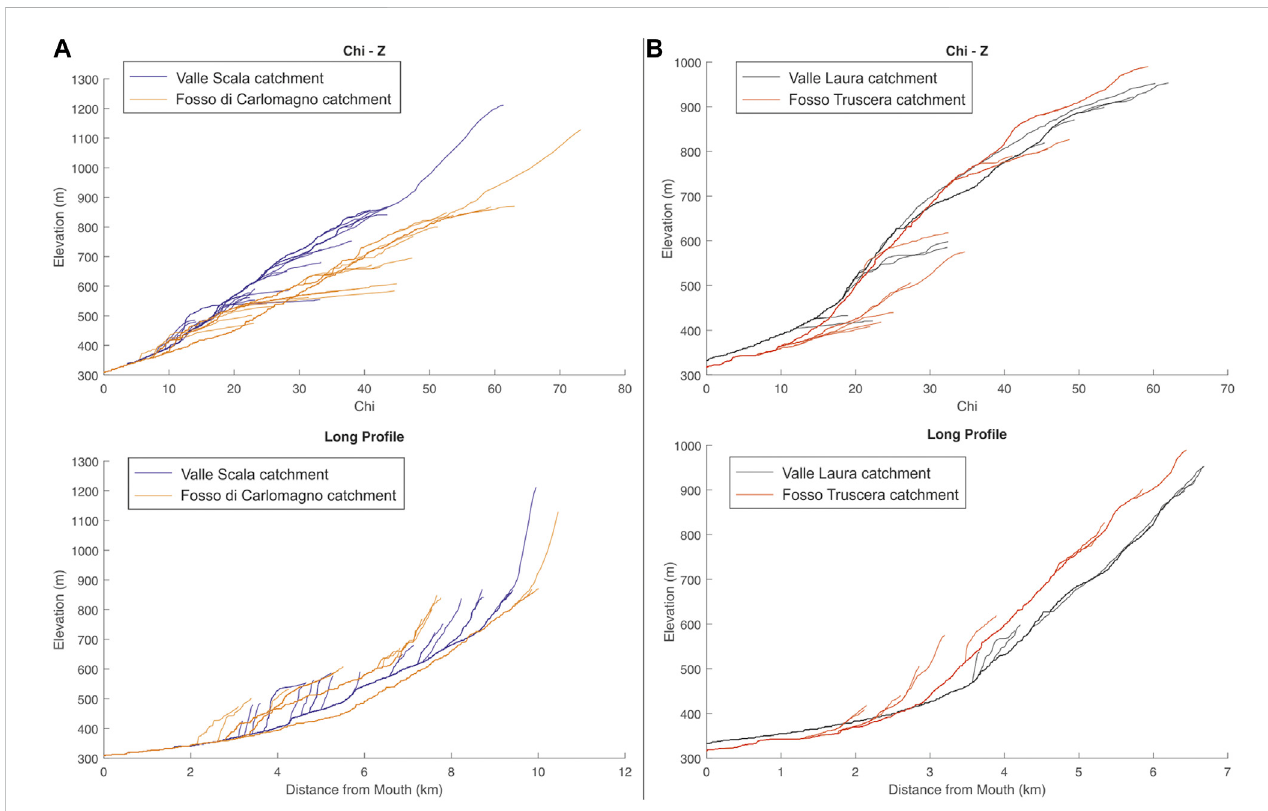
FIGURE 8 Comparison between river pro fi les and chi plots for two catchments located in southern (A) and northern (B) sectors of the study